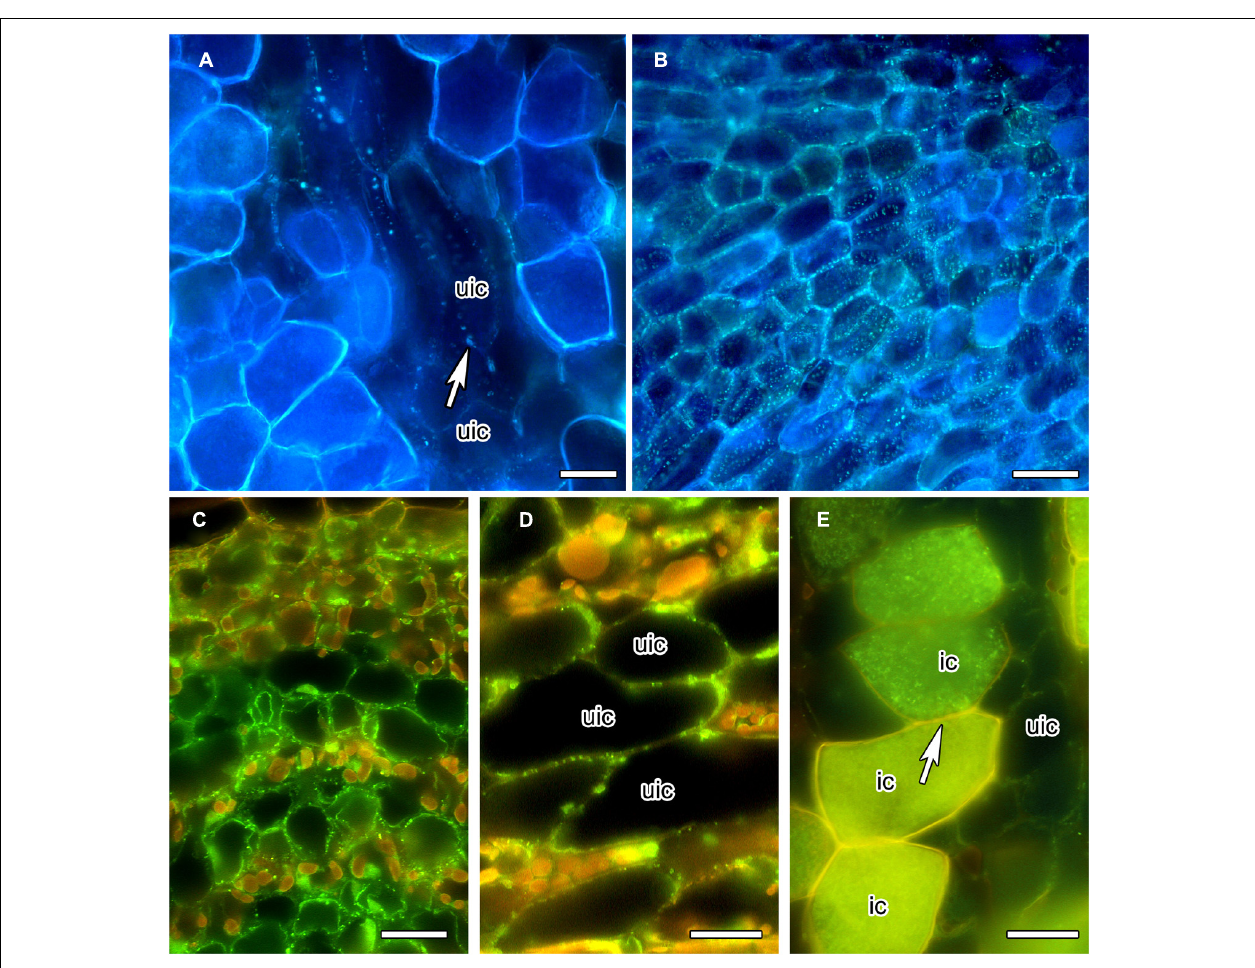
[recognizablebytheirfluorescentcellwalls;labelingshouldbevisiblebecause thefluorescenceofAnilinBlue,asobviousin (B) whichshowsayoungerareaof thecortexbeforetheonsetofinfection,ismoreyellowishthenthe fluorescenceofthewallsofinfectedcells]. (C) Callosesynthaseisdetectedin theplasmamembranesofuninfectedcorticalcellsintheyoungestpartofthe cortex,closetotheapicalmeristem.Intheolderpartofthecortex– (D) shows theoutercortexinthezoneofnitrogenfixation–thelabelingislessdense. (E) Nolabelingwasseenintheplasmamembranesofinfectedcells(ic;arrow). Sizebarsdenote20 μ min (A–D) and25 μ min (E)